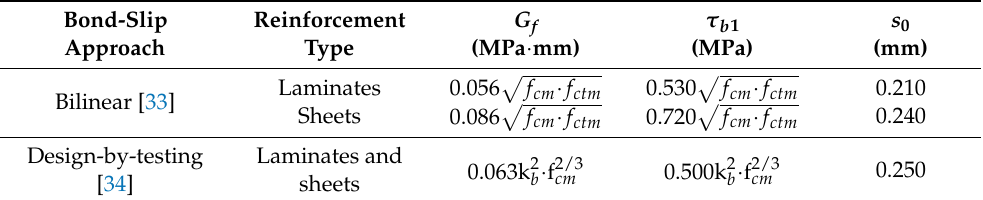
Table 1. Suggested mean values for the parameters in the bilinear bond law [33,34]. Bond-Slip